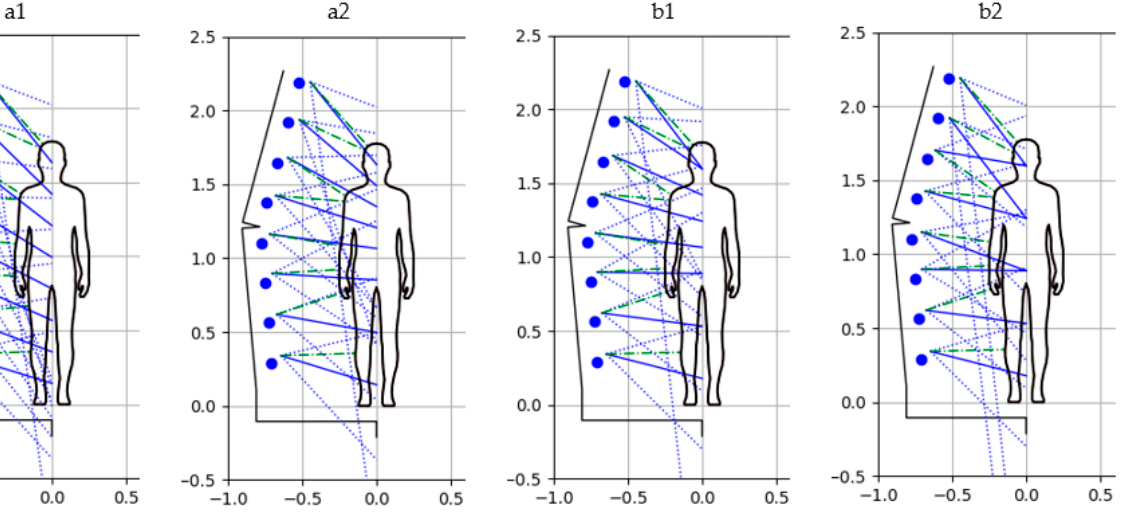
Figure 9. The illustration of camera configuration and visibility for particular